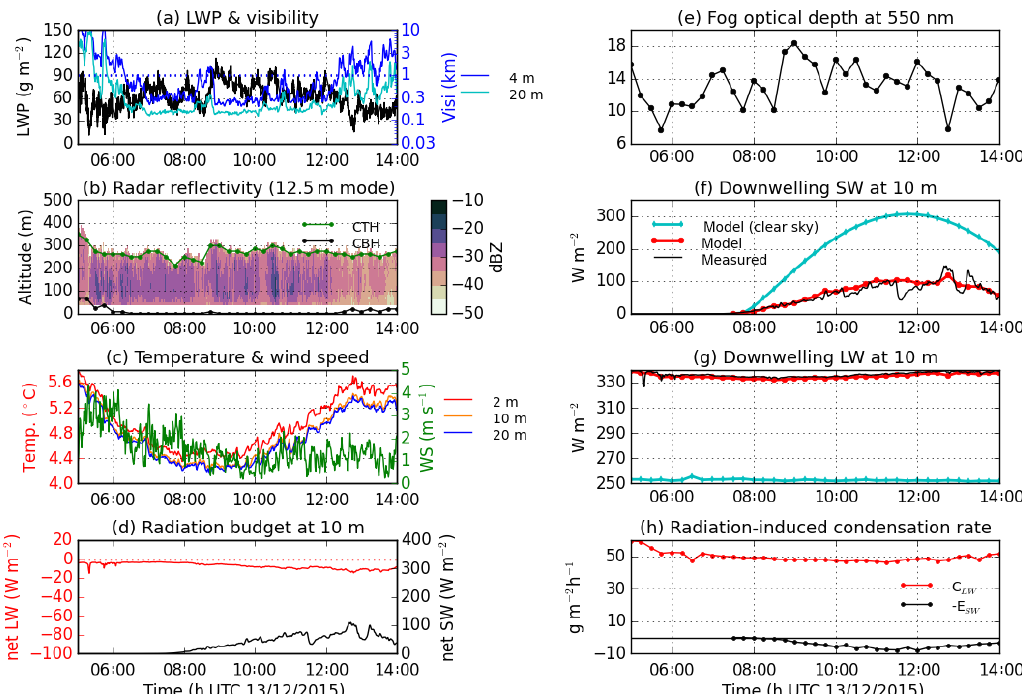
Figure 4. Same as Fig. 3 but for the fog event on 13 December